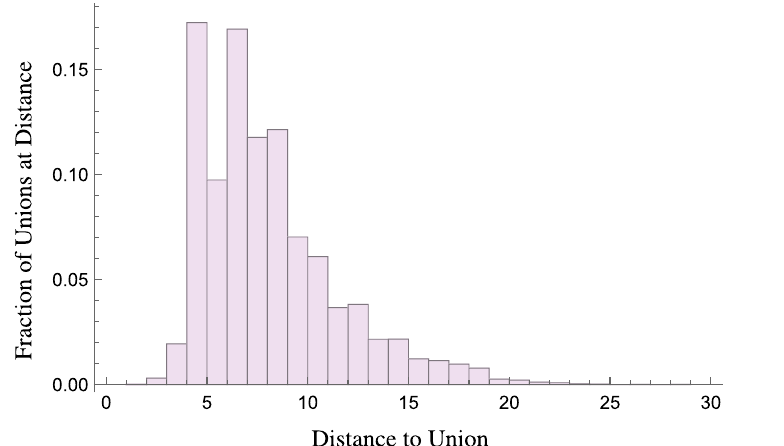
Fig. 2 The histogram representing the finite “distance to union” distances is shown where data is collected from 104 genealogical networks from kinsources.net. The height of each bar represents the fraction of unions that form at a specific